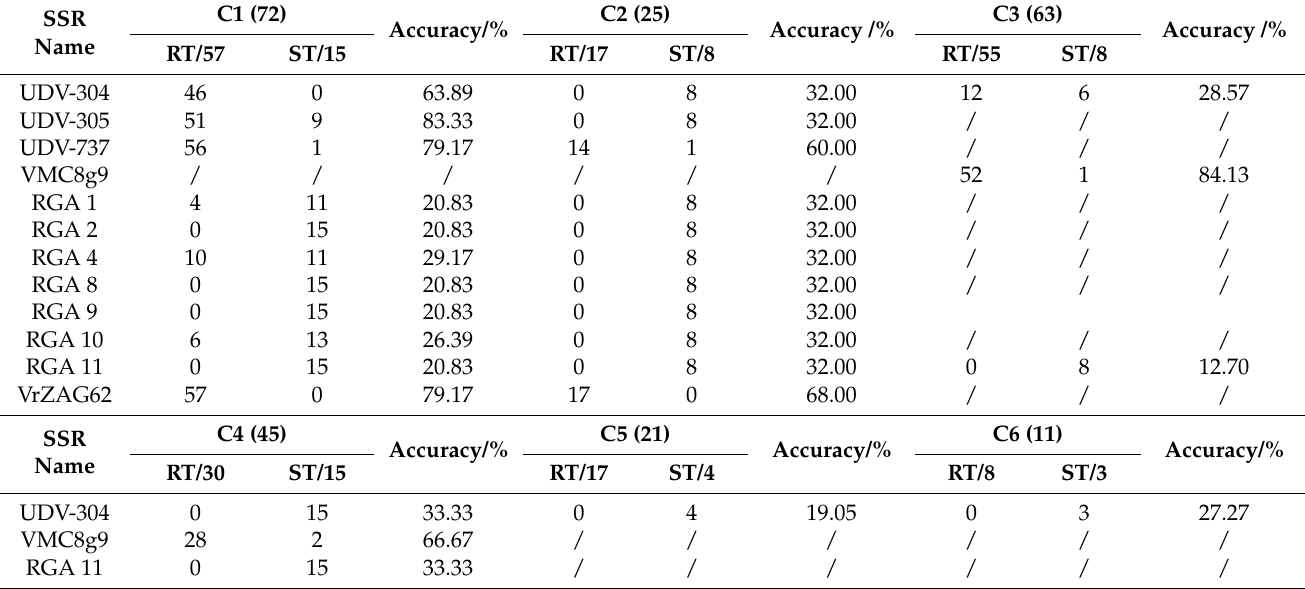
Table 10. The results for six combinations detected by ten SSR molecular